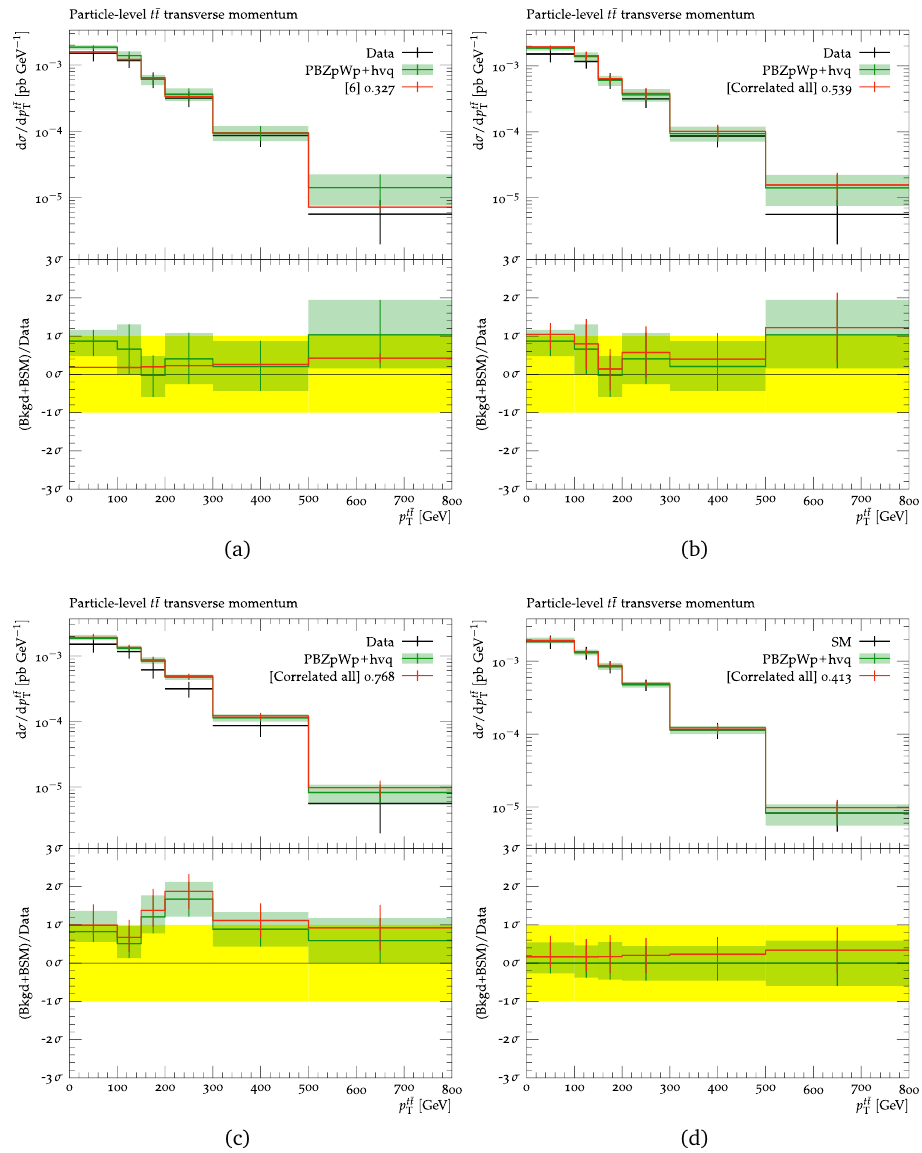
Figure 3: ATLAS all-hadronic boosted t ¯ t measurement, and PBZpWp signal for / M = 0.5. Transverse momentum distribution for t ¯ t , (a) using = 4.56 TeV, Γ M Z ′ Z ′ Z ′ data as background, (b) using NLO SM as background, (c) using NNLO SM as back- ground, (d) Expected exclusion using NNLO SM prediction for background. In each case the black points are the measurement, the red histogram is the SM background + BSM signal, and the green is the SM prediction. The lower insets show the ratio of the signal plus background to the measurement, with the yellow band indicating the combined 1 σ uncertainty on the ratio, and the green band indicating the uncertainty on the SM